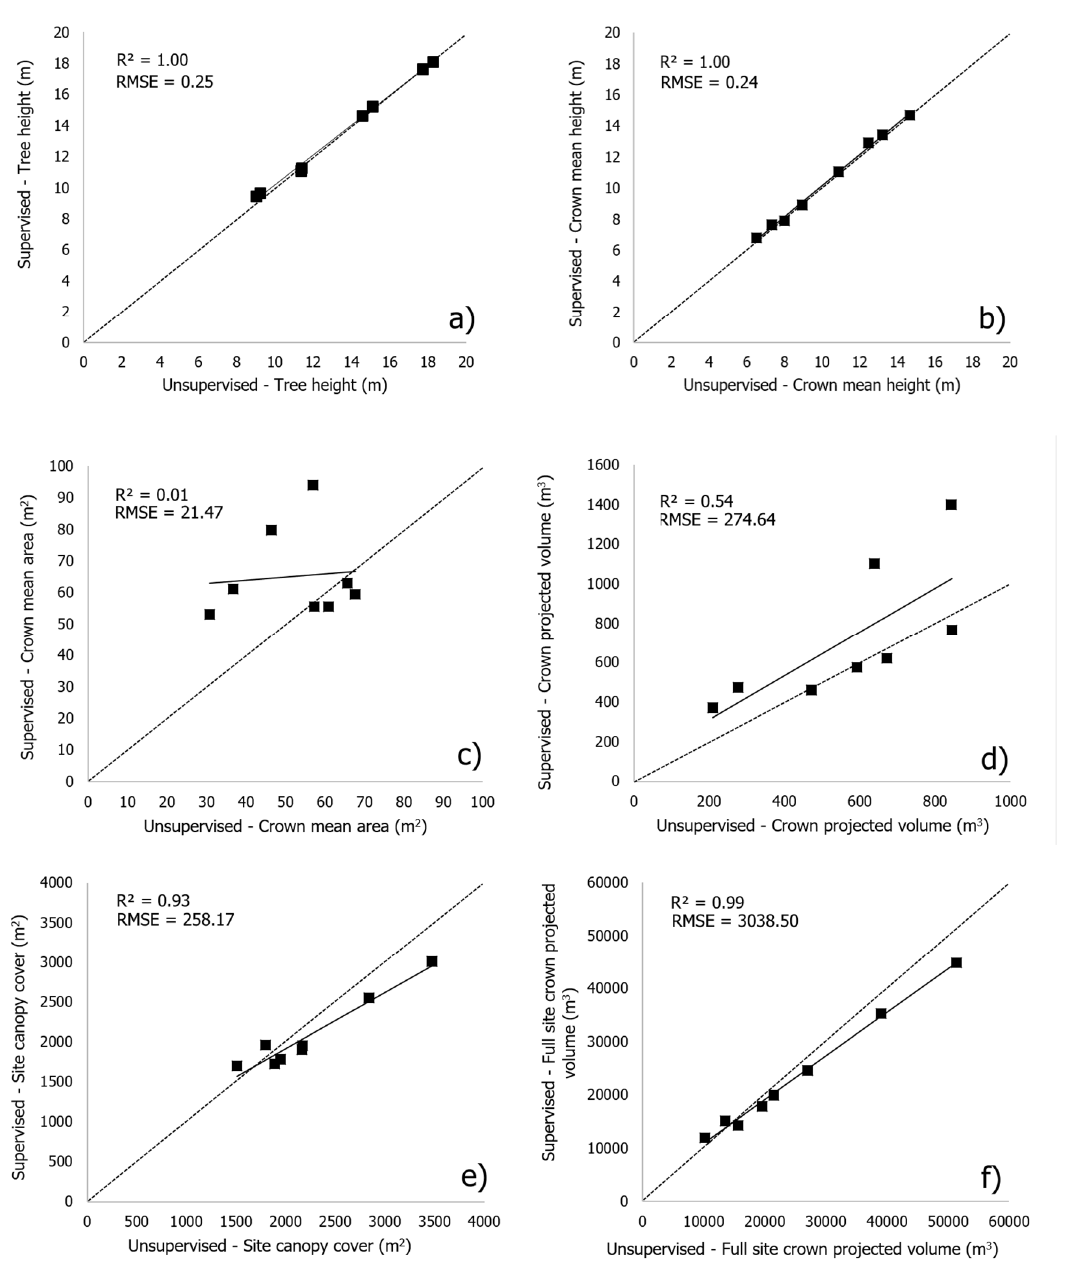
Figure 4. Comparison performance between supervised and unsupervised segmentation within 4 sites for 2017 and 2018 season to characterize geometric information: tree height ( a ), crown mean height ( b ), crown mean area ( c ), crown projected volume ( d ), full site canopy cover ( e ), full site crown projected volume ( f ).